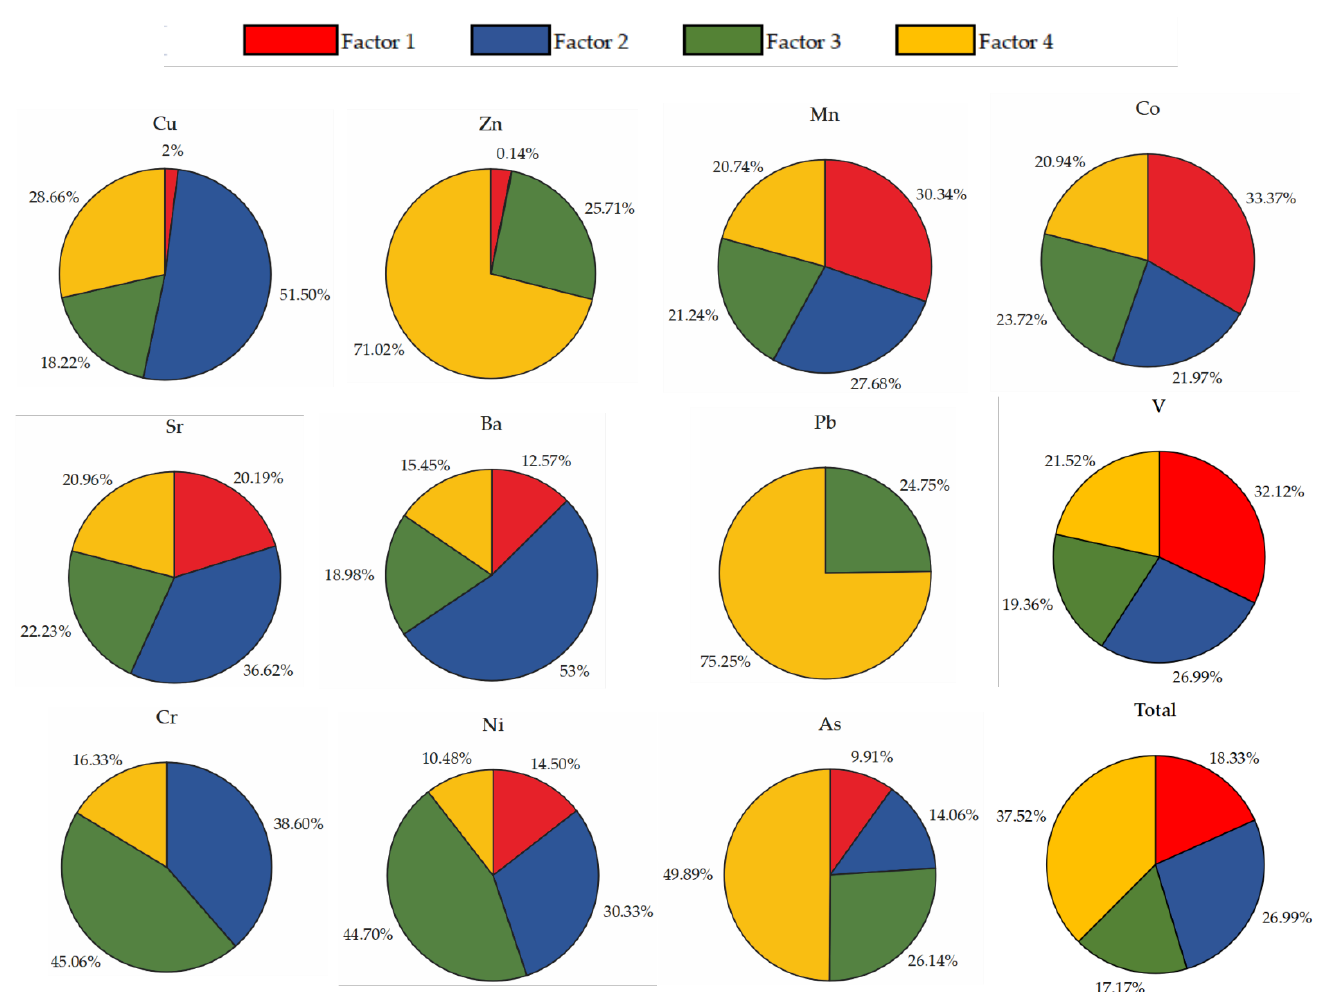
Figure 4. The contribution rates of different sources by the PMF model. As can be seen from Figure 4, the components of V, Mn, and Co are the highest in factor 1, Cu, Sr, and Ba were the highest in factor 2, Cr and Ni were the highest in factor 3, and As, Zn, and Pb were the highest in factor 4, indicating that they represent different pollution sources, respectively. Combined with the above correlation analysis results, the source analysis results of the PMF model showed that the contribution rate of factor 1 to V, Mn, and Co was 32.12%, 30.34%, and 33.37%, respectively, indicating that these three elements were mainly affected by factor 1. V and Mn were usually the indicator elements of the crust and were mainly affected by the loess in the recent Holocene. The source of Co was related to the lead-zinc ore and iron ore [48], but more studies have shown that Co was influenced by the soil parent material [49]. The contribution values of the four pollution factors at each sampling point were obtained through the analytic results of the PMF model, and the spatial distribution maps of different pollution sources in the study area were drawn according to the contribution values, as shown in Figure 5. The high-value sample of the factor 1 contribution was located at the foot of the Beishan in the Qinzhou District and the turning point of the Weihe River basin in the Maiji District, which may be due to the low overall terrain of the study area and because heavy metals are prone to being contamination by river impacts [48]. Meanwhile, according to the statistics of heavy metal concentration in the surface dust of the bus stop mentioned above, the concentration values of V, Mn, and Co elements in all sample points were lower than the background values, and the excessive rate was zero with weak variability and little influence by anthropogenic activities, indicating that the source was mainly related to the natural parent